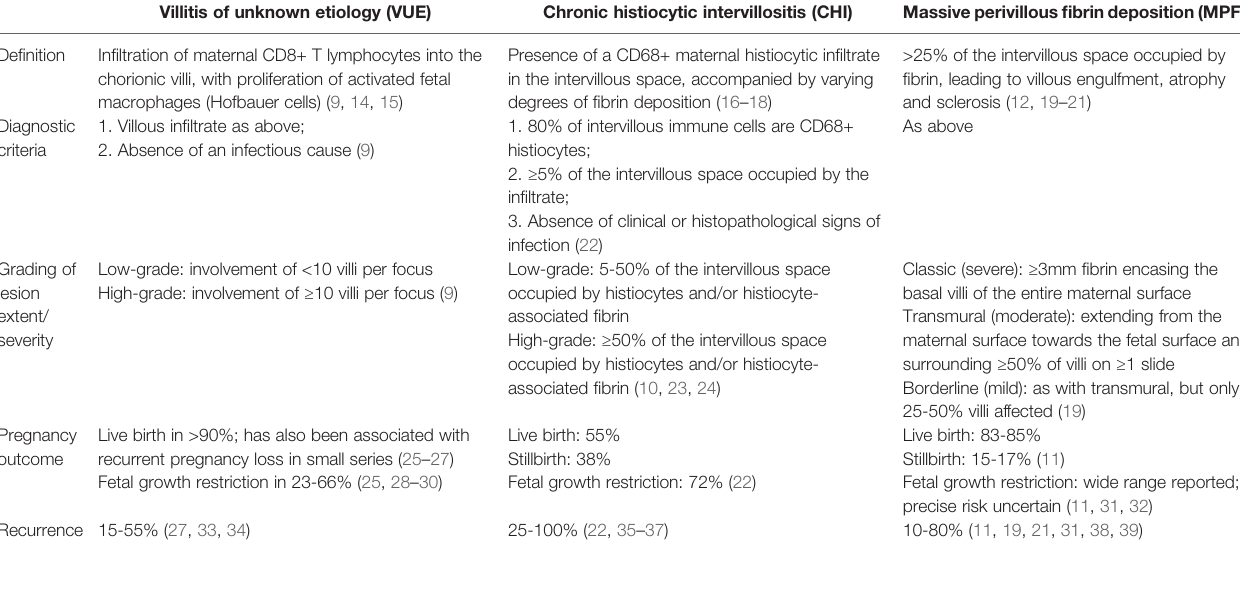
TABLE 1 | De fi nitions, diagnostic criteria, severity grading and key obstetric outcomes for three chronic in fl ammatory placental disorders associated with recurrence risk: villitis of unknown etiology (VUE), chronic histiocytic intervillositis (CHI) and massive perivillous fi brin deposition